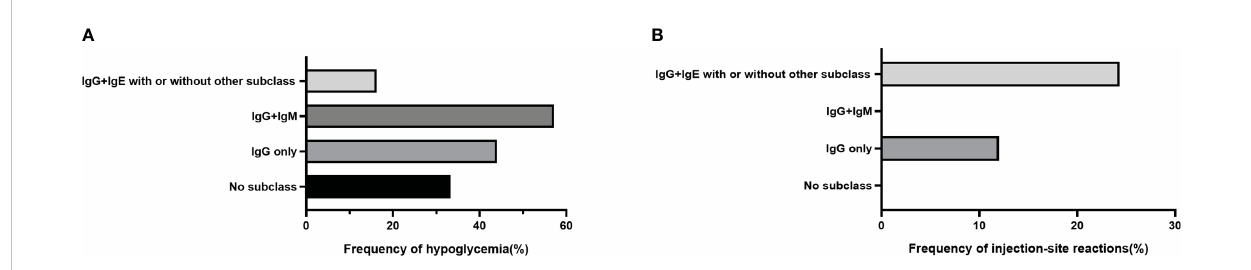
FIGURE 6 Frequency of hypoglycemia or injection-site reactions in the IA-positive group strati fi ed by IA subclasses. (A) shows 2 of 6 (33.33%), 18 of 48 (37.50%), 4 of 7 (57.14%), and 6 of 37 (16.21%) patients with no subclass, IgG-IA alone, IgG-IA and IgM-IA, or IgG-IA, IgE-IA whether with or without other subclasses had hypoglycemia respectively. (B) shows 4 of 48 (8.30%), and 9 of 37 (24.32%) patients with IgG-IA only, or IgG-IA, IgE-IA, whether with or without other subclasses had injection-site reactions, respectively; other groups had no local